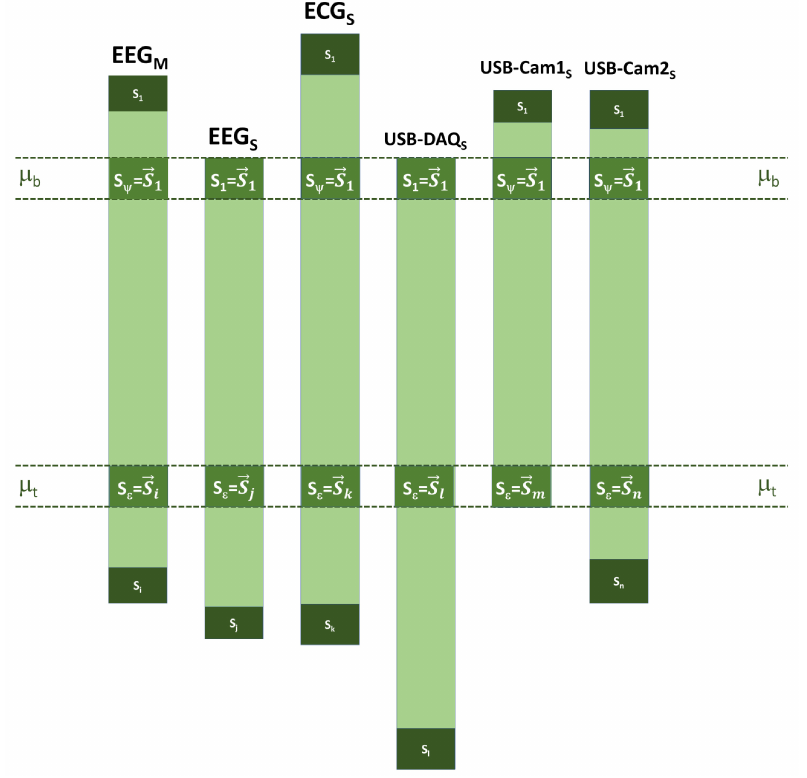
Figure 16. Synchronization